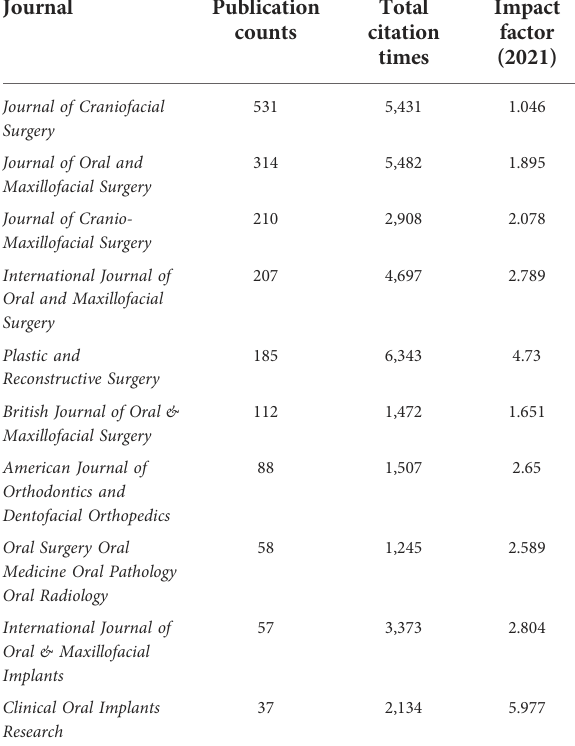
TABLE 3 The top 10 most productive journals contributing to the research on craniomaxillofacial distraction osteogenesis from 2000 to